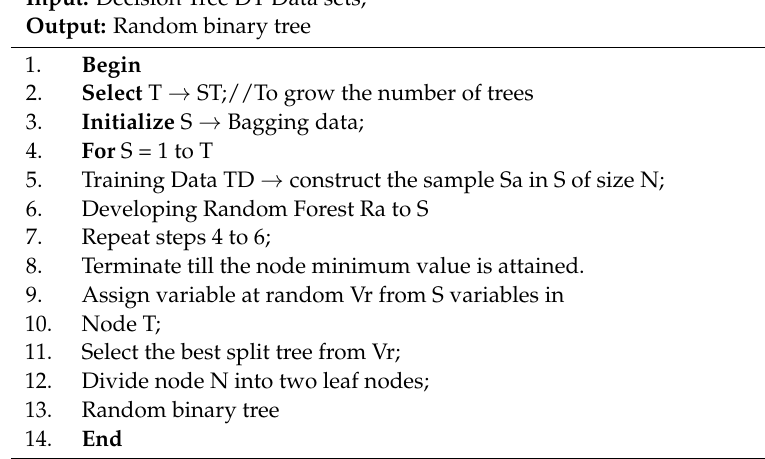
Algorithm 2. Modified Random